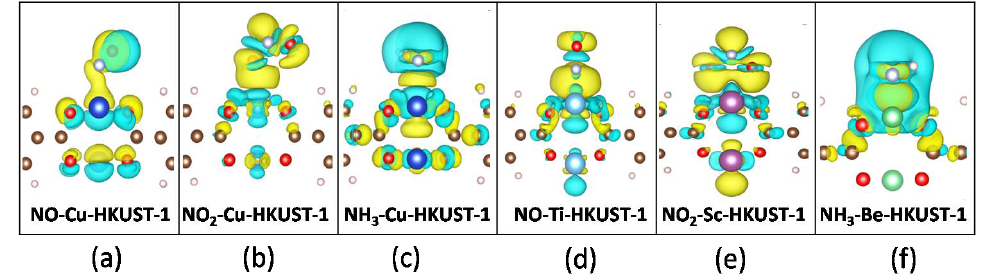
Figure 5. Selected electron density difference map for NCC molecules adsorbed on M-HKUST-1: ( a ) NO on Cu-HKUST-1, ( b ) NO 2 on Cu-HKUST-1, ( c ) NH 3 on Cu-HKUST-1, ( d ) NO on Ti-HKUST-1, ( e ) NO 2 on Sc-HKUST-1, and ( f ) NH 3 on Be-HKUST-1. For each case, only the most stable adsorption configuration is considered. Accumulation region in yellow and depletion regions in blue.